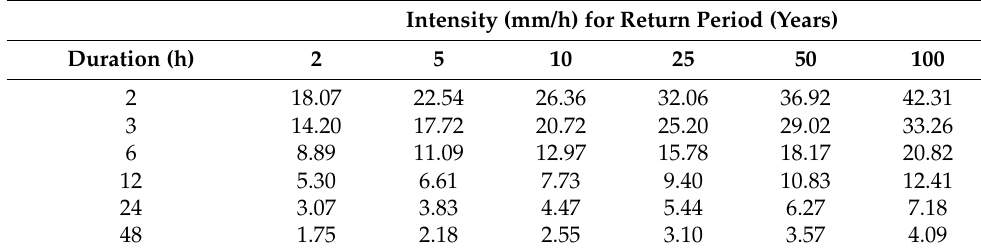
Table 4. Intensity (mm/h) for various rainfall durations (2 to 48 h) and for return periods ranging from 2 to 100 years.